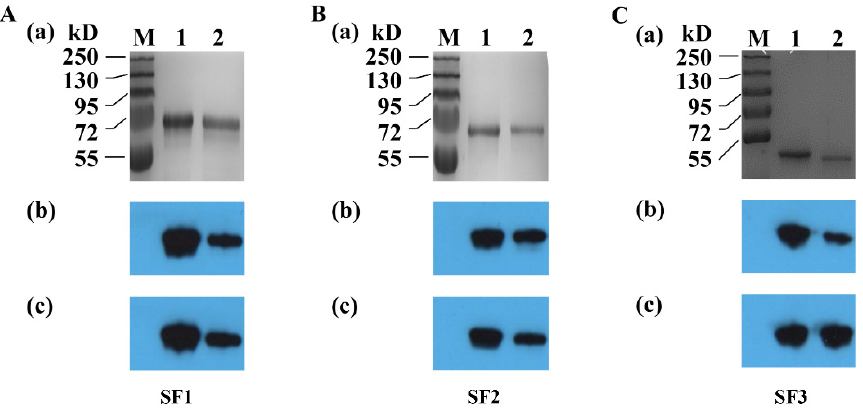
Figure 4. Reactivity of anti-S protein fragment 1 (SF1) sera with SF1 ( A ), anti-SF2 serum with SF2 ( B ), and anti-SF3 serum with SF3 ( C ). ( a ). SDS-PAGE analysis of purified SFs. ( b , c ). Western blot analysis with anti-SFs of PEDV CV777 (SFs CV777 ) and anti-SFs of PEDV SD2014 (SFs SD2014 ) sera as the primary antibody, respectively. Lane M: Protein marker; lane 1 and 2: Purified SFs CV777 and SFs SD2014 , respectively.